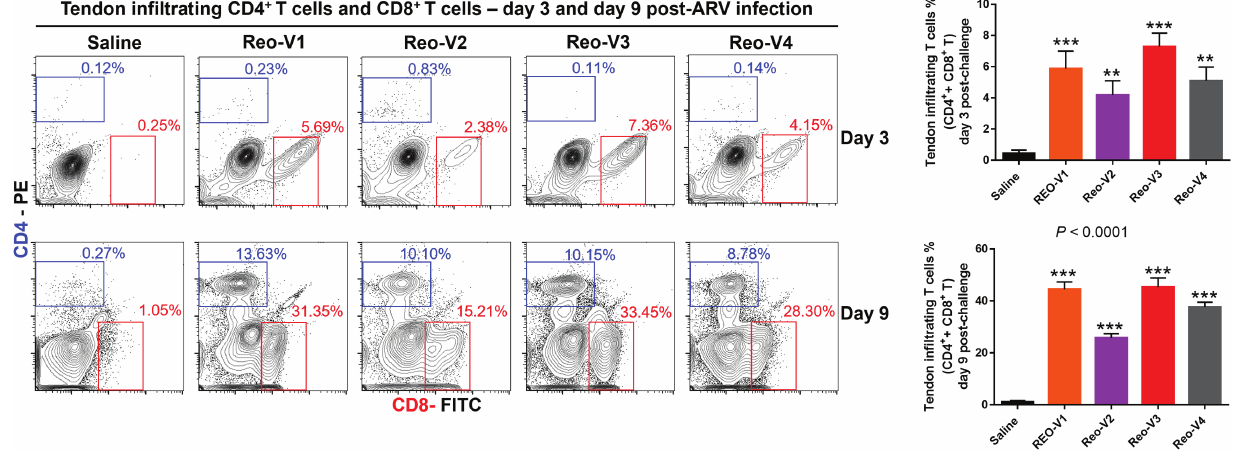
FIGURE 7 | Flow cytometry analysis of sub-populations of CD4 + and CD8 + T lymphocytes in the tendon tissues of birds infected with ARVs [i.e., Reo-V1 (Cluster-5), Reo-V2 (Cluster-4), Reo-V3 (Cluster-2), or Reo-V4 (Cluster-6)] at day 3 and day 9 post-infection. The bar graph: the tendon tissue infiltrating mean (±SD) combined CD4 + and CD8 + T lymphocyte percentages at day 3 and day 9 post-infection based on three separate experiments. Asterisks indicate groups that were significantly different from the control group, ** p < 0.001, and *** p <